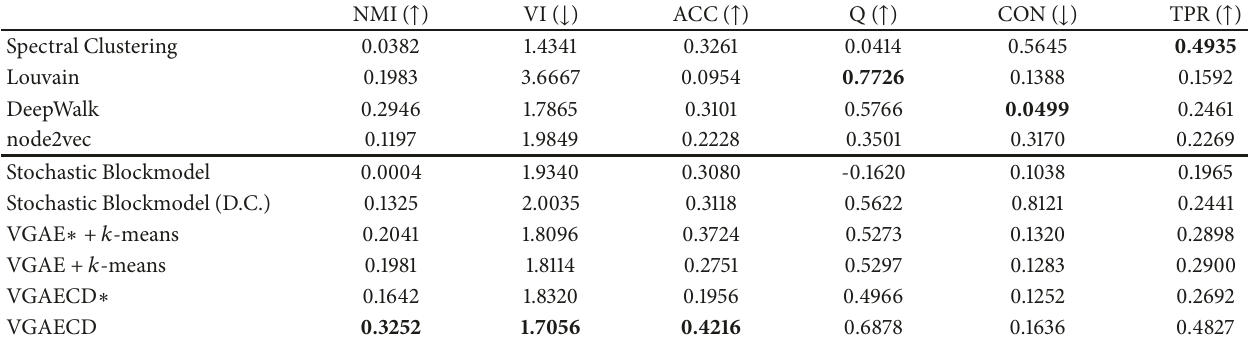
Table 5: Experimental results on PubMed